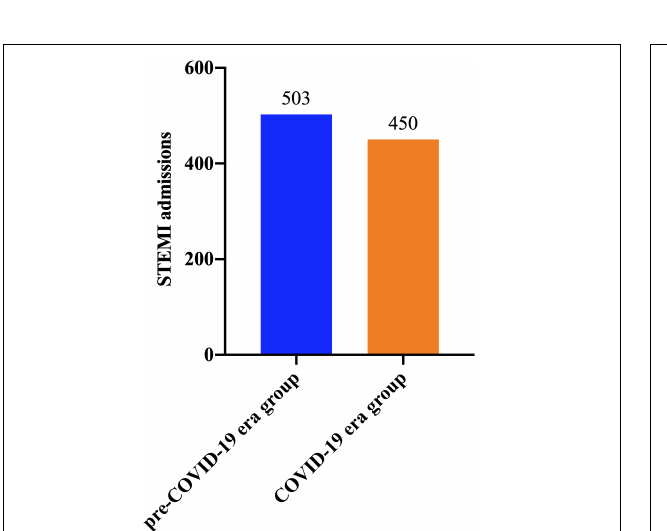
FIGURE 3 | Reperfusion strategy for STEMI patients during Wuhan lockdown and equivalent time period in 2019. STEMI, ST-segment elevation myocardial infarction; COVID-19, coronavirus disease 2019; PPCI, primary percutaneous coronary